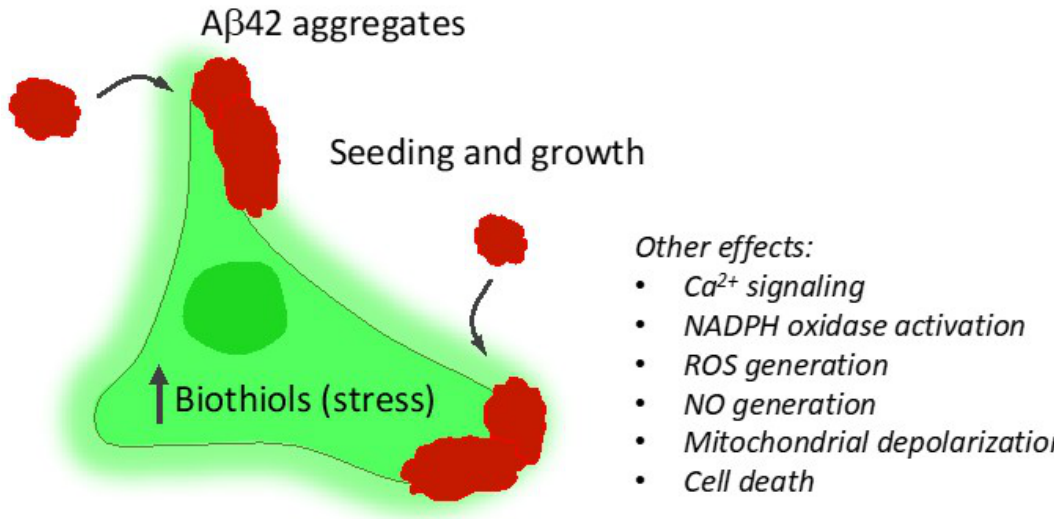
Figure 9. Main findings in this work. A β 42 aggregates are bound to the cell membrane, acting as seeds for further growth. This membrane interaction is accompanied by increased cellular oxidative stress, finally leading to lysis and cell